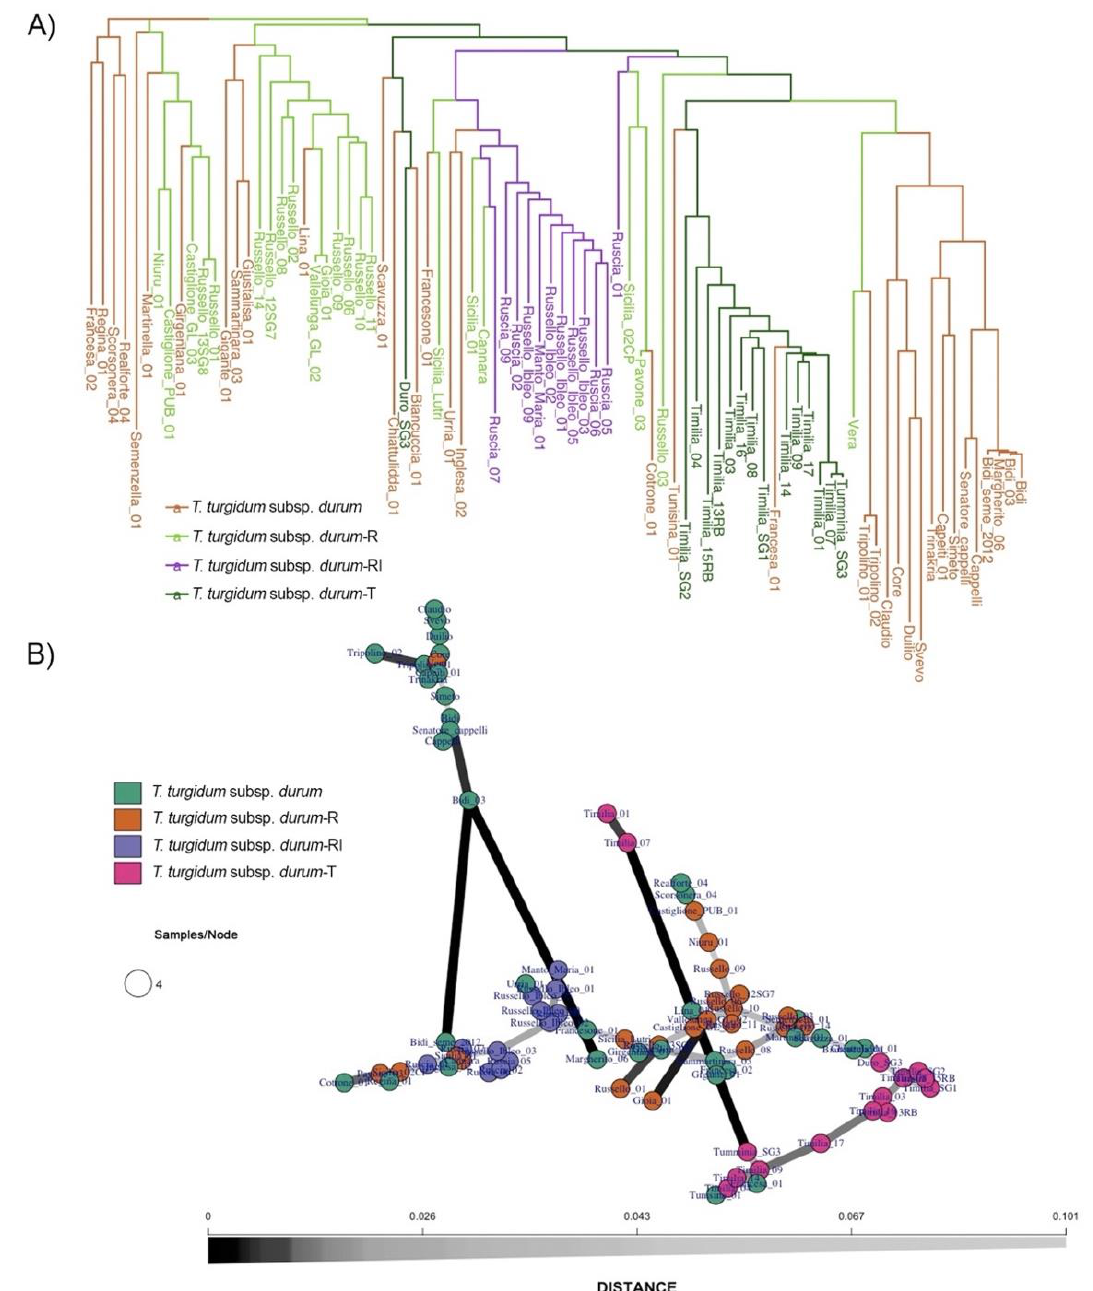
Figure 5. ( A ) NJ tree based on SNP profiles of varieties belonging to T. turgidum subsp. durum : T. turgidum subsp. durum , T. turgidum subsp. durum -R (‘Russello’), T. turgidum subsp. durum -RI (‘Russello Ibleo’), and T. turgidum subsp. durum -T (‘Timilia’). ( B ) A minimum spanning network (MSN) showing the multilocus genotypes (MLG) of accessions belonging to T. turgidum subsp. durum subset. The distances between the MLGs indicates Nei’s genetic distance; each MLG is a node and the genetic distance is represented by the edges. The nodes are connected by the minimum distance between samples, which allowed for reticulations. The grey scale of the edges is proportional to the genetic distance; the lines become darker for more-related nodes.